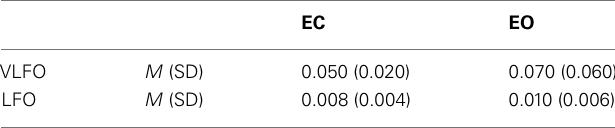
M, mean; SD, standard deviation; EC, eyes-closed resting state; EO, eyes- open resting state; VLFO, very low-frequency oscillations; LFO, low-frequency